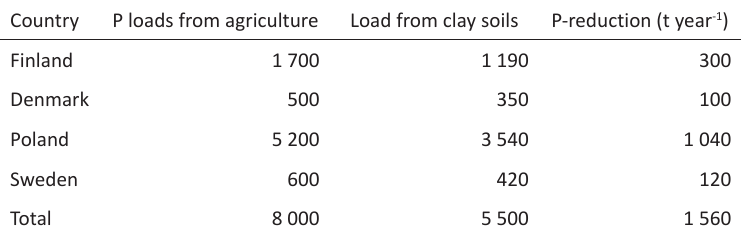
Table 5. Preliminary estimate of phosphorus reduction resulting from gypsum amendment in Finland, Denmark, Poland and